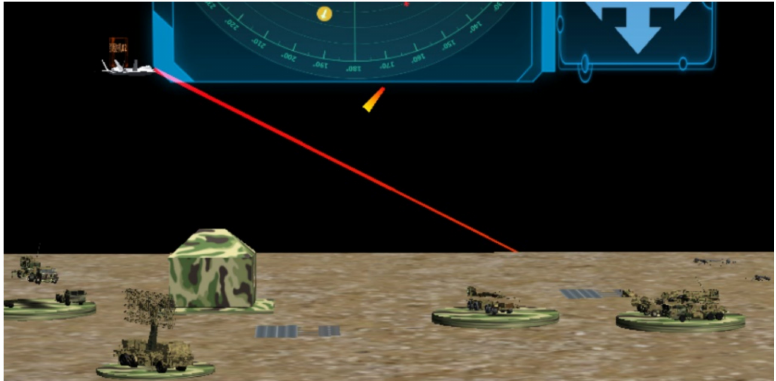
Figure 7. Schematic diagram of blue-side aircraft target